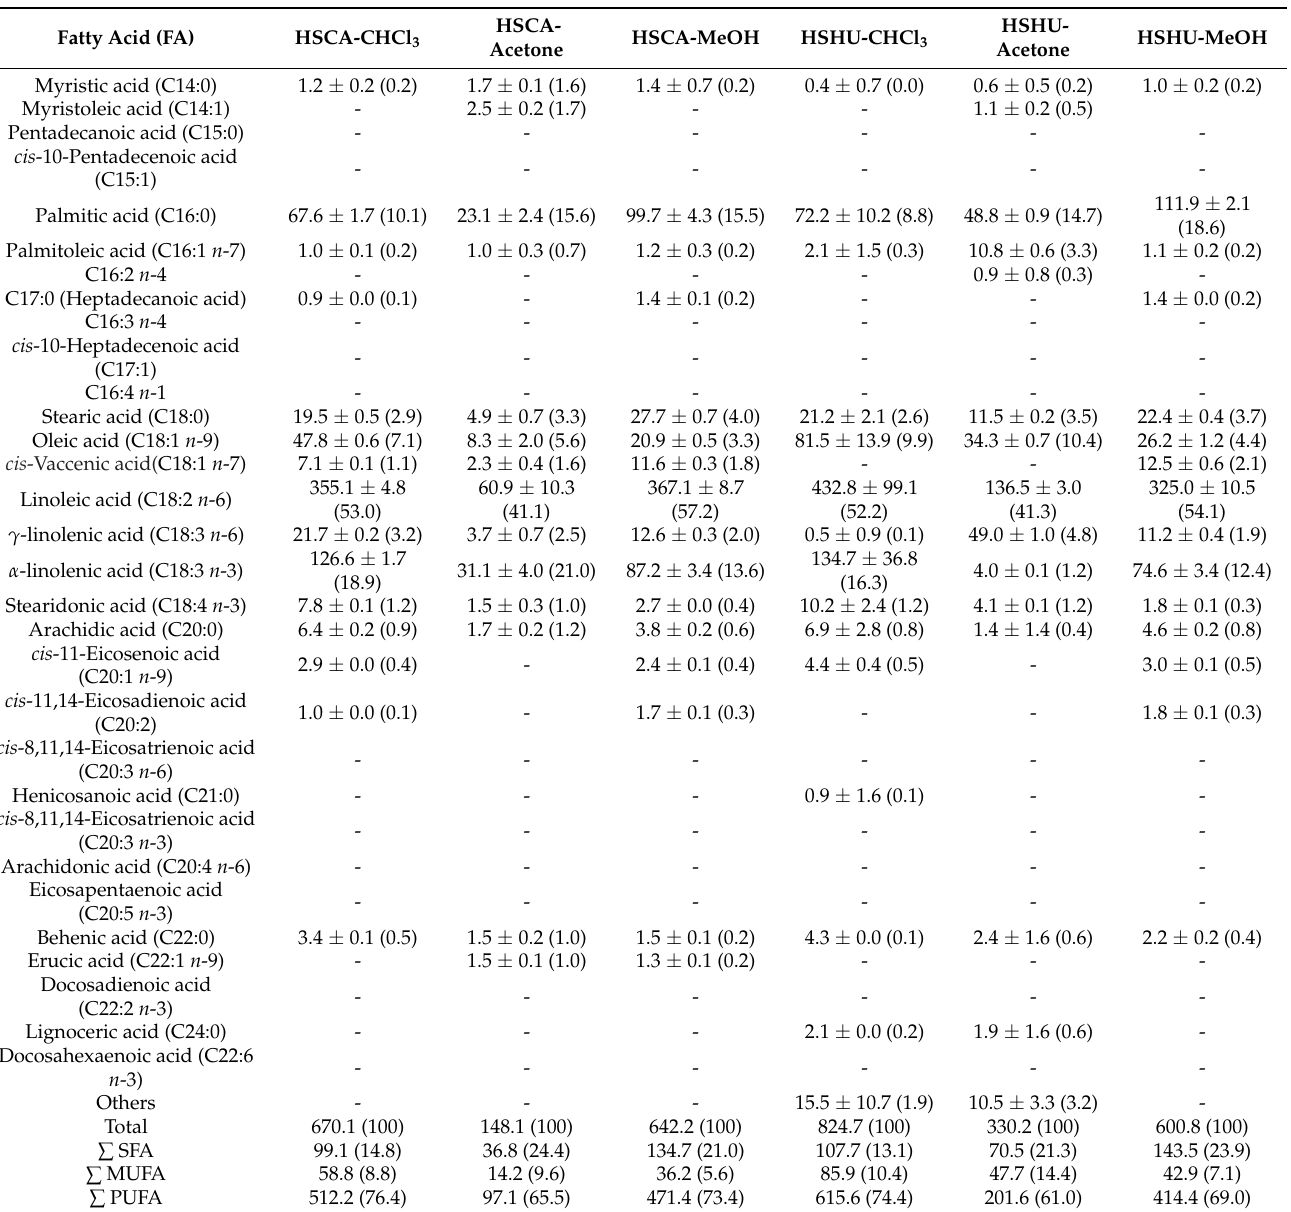
Table 4. Fatty acid profile of chloroform, acetone and MeOH fractions after SPE of hemp cake (HSCA) and hemp seed hulls (HSHU). Results are expressed in mg/g